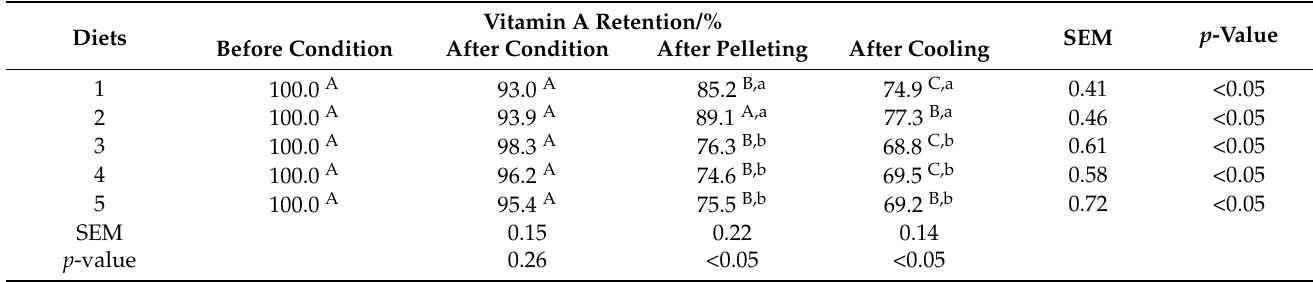
Table 4. The retention of vitamin A in diets during pelleting and the long-term high-temperature stabilization